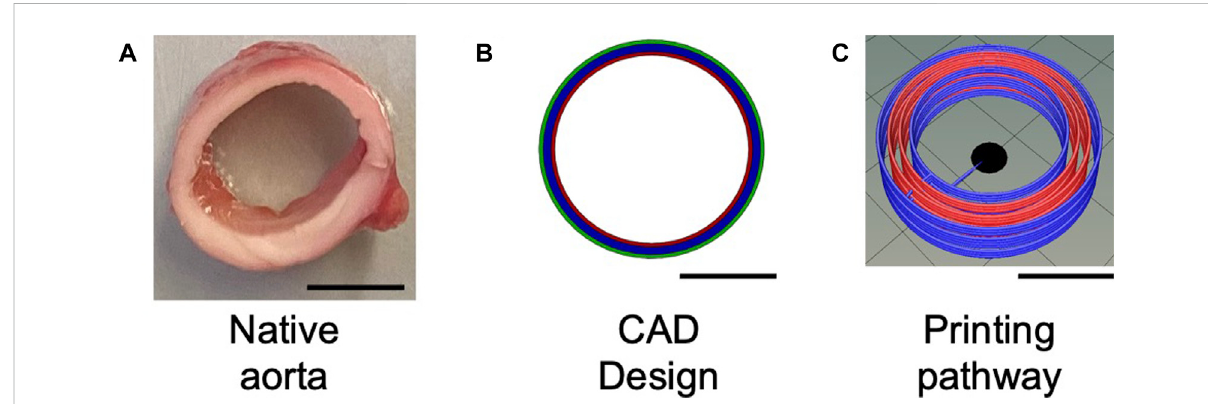
FIGURE 3 Ageometricalmodelofthehierarchicalstructureoftheaorta.Inparticular: (A) Nativeaorta; (B) CADmodeloftheaortaconstruct,basedonthe real anatomical dimensions of the aorta; (C) Printing pathway. In (B) the three layers of the native aorta are identi fi ed: in red the intima layer, in blue the media layer, and in green the adventitia layer, whereas in (C) the latter is in blue as well. (Scale bar = 10